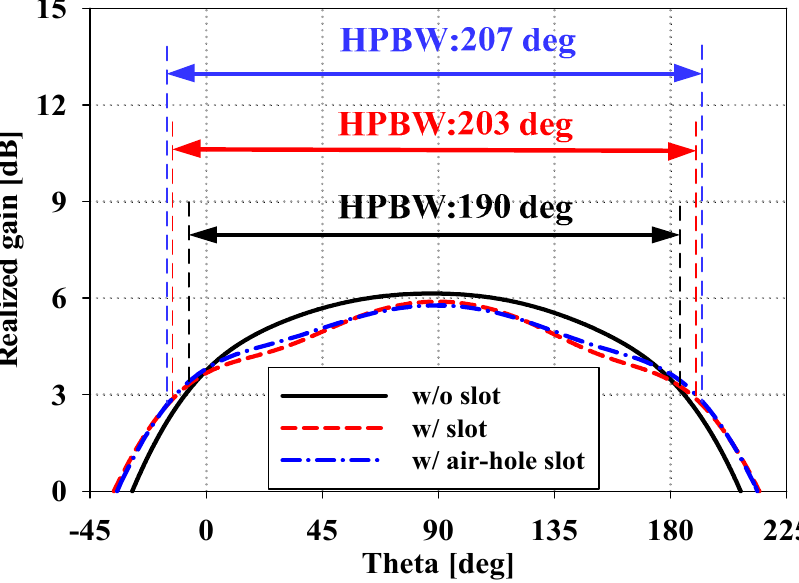
Figure 7. Comparison of HPBW at 28 GHz in the YZ plane for the supposed three cases.